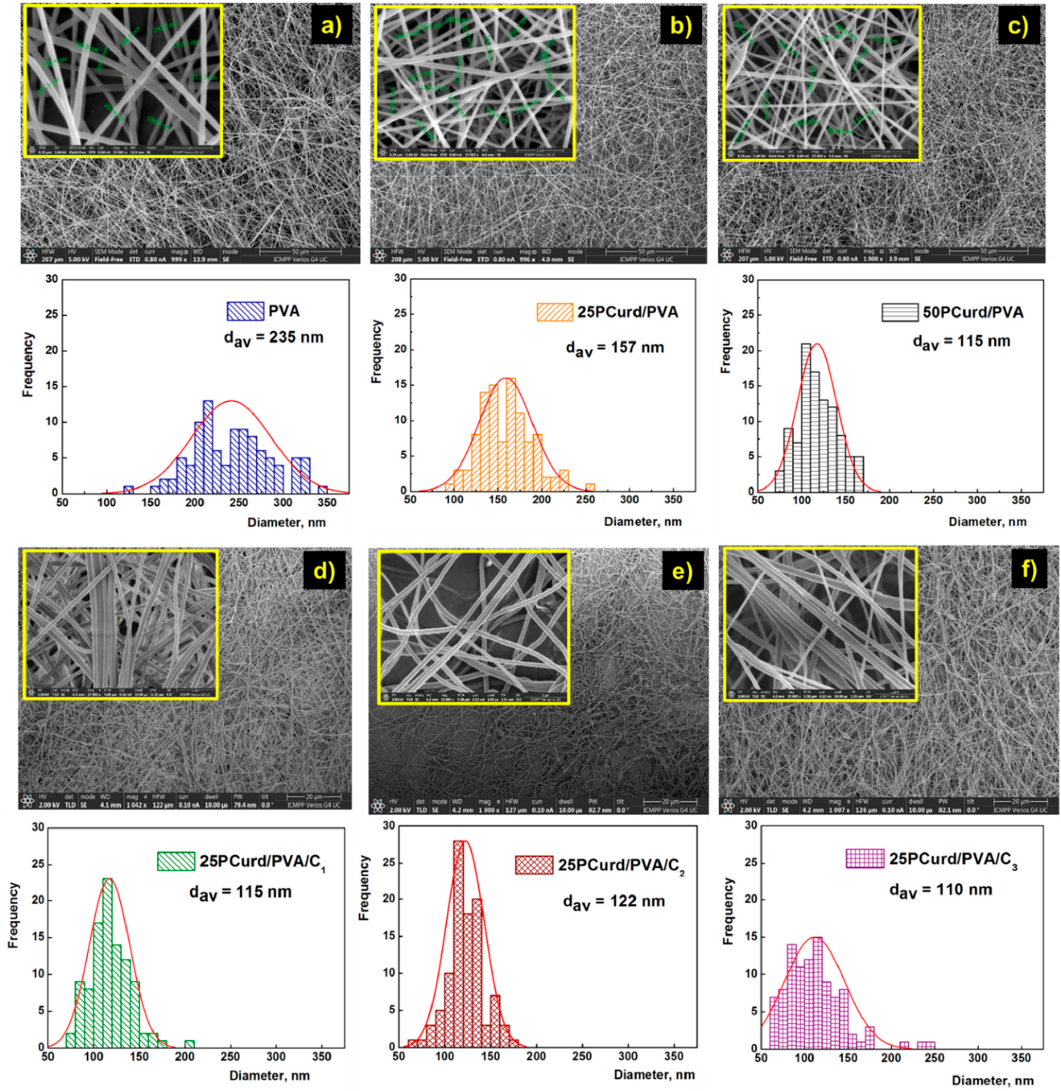
Figure 3. Scanning electron micrographs of the electrospun nanofibre membrane with and without clove essential oil (general view with detail and size distribution): PVA ( a ), 25PCurd/PVA ( b ), 50PCurd/PVA ( c ), 25PCurd/PVA/C 1 ( d ), 25PCurd/PVA/C 2 ( e ), and 25PCurd/PVA/C 3 ( f ) membranes. Table 2. The composition and the main characteristics in terms of composition of the PCurd/PVA nanofibre